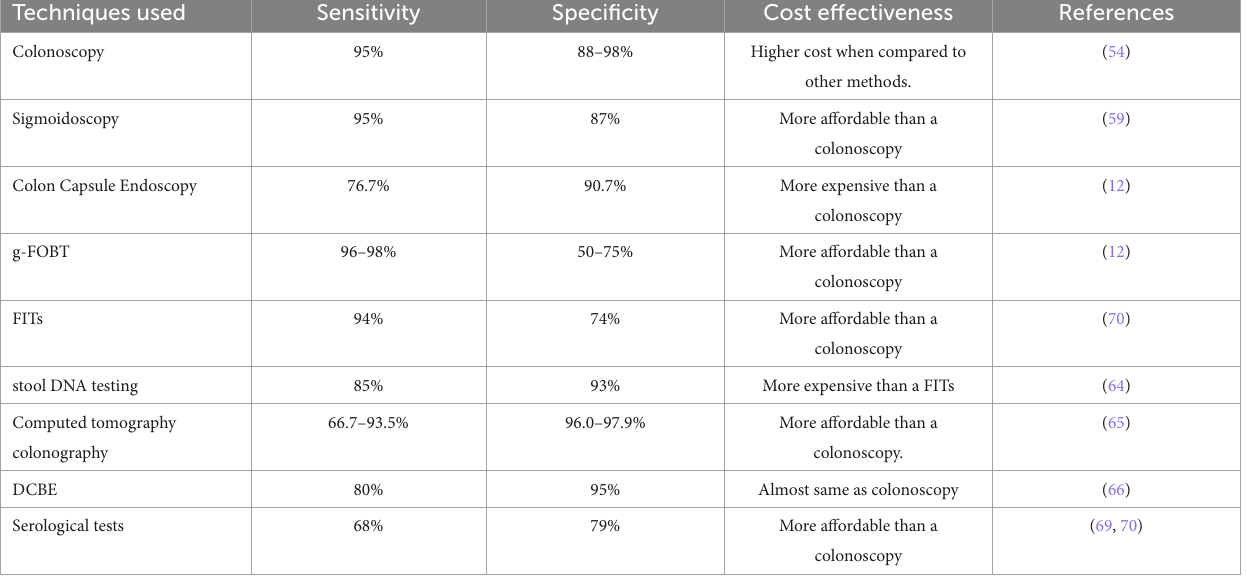
TABLE 2 Summary of detection techniques used for CRC detection based on cost-effectiveness. Techniques